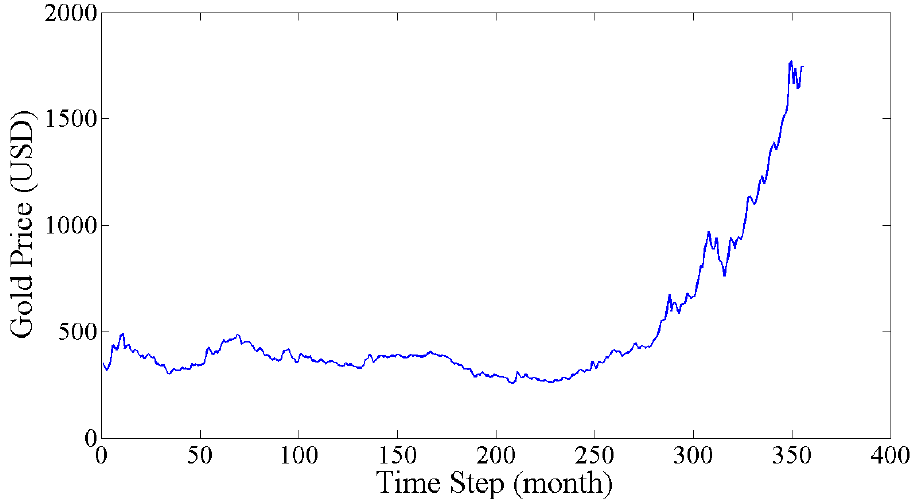
Figure 3. The study’s data set for gold prices.